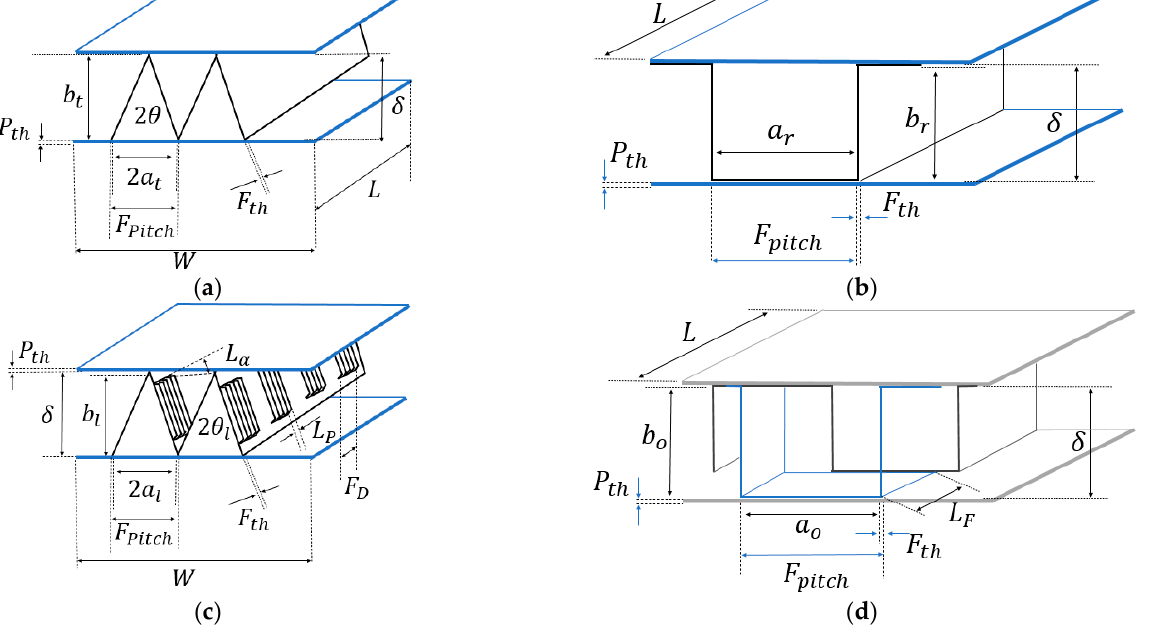
Figure 1. Geometry of finned surfaces: ( a ) triangular, ( b ) rectangular, ( c ) louvered, ( d ) offset strip-fin. The hydraulic diameter is a function of the free flow area and is determined as: